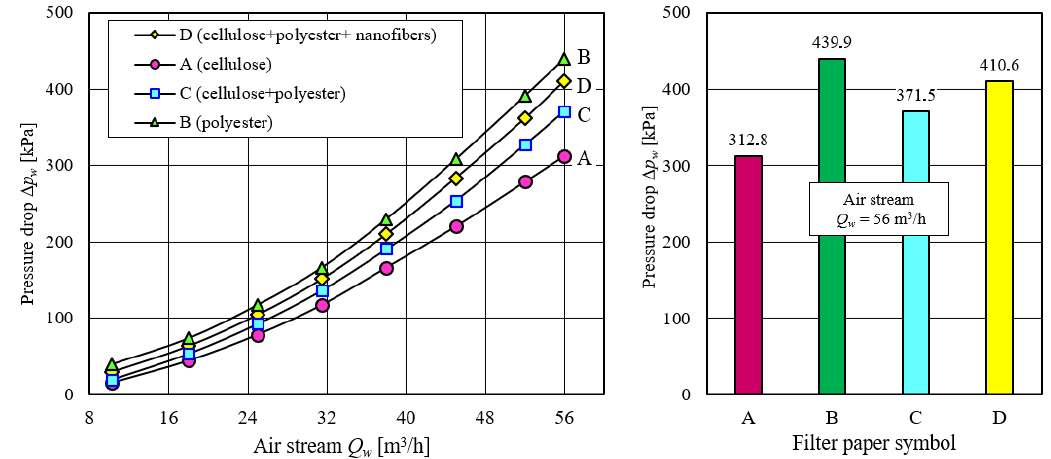
Fig. 12. Flow characteristics  p w = f(Q w ) of tested filter cartridges A, B, C, D